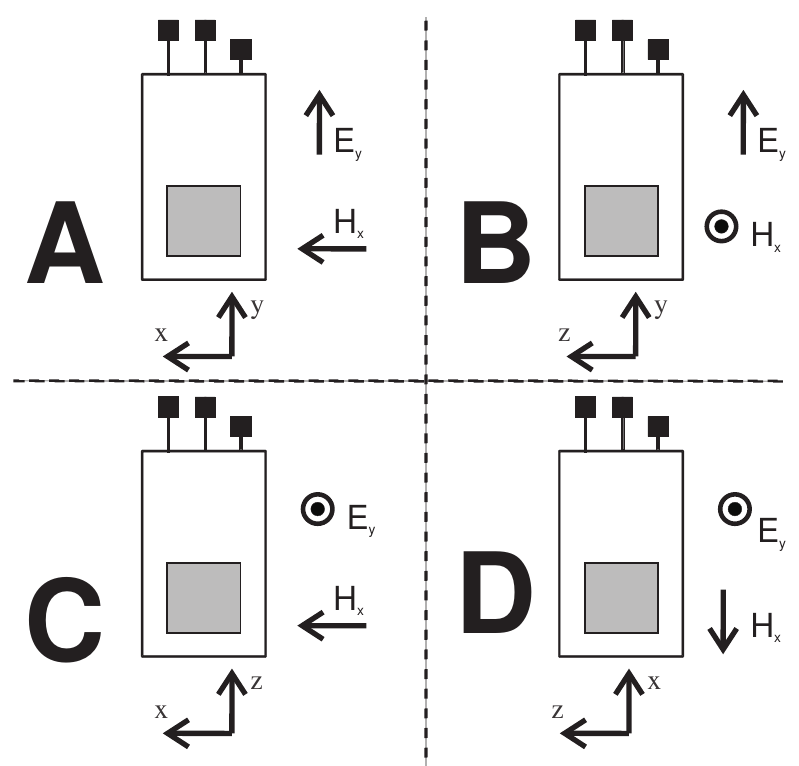
Figure 12. Magnetic and electric field orientation for different Hall sensor setup.